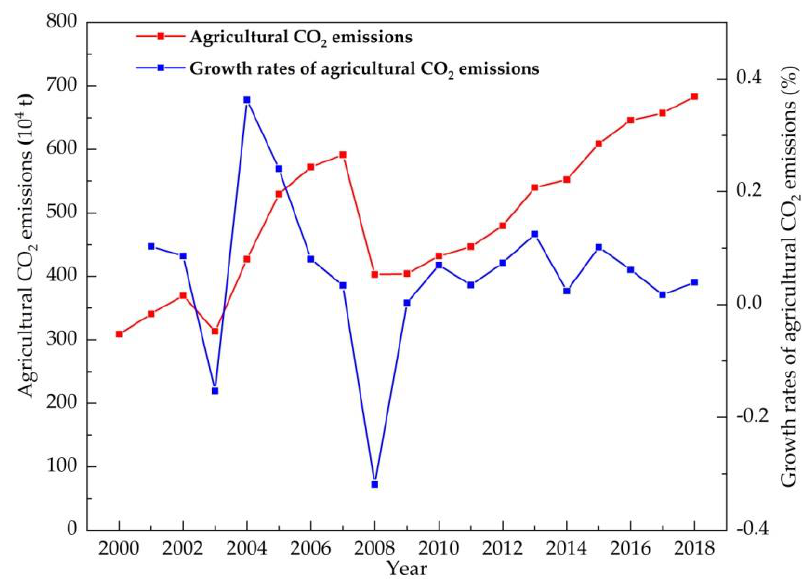
Figure 1. Agricultural CO 2 emissions and growth rates in Jilin province during 2000–2018.